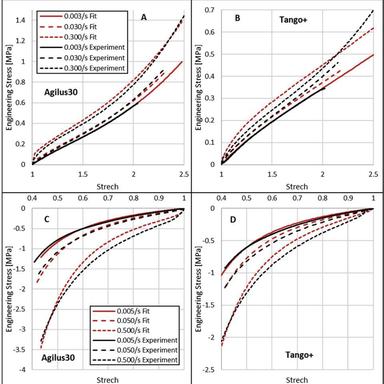
The visco-hyperelastic material model prediction vs. experiment for A30 and T+ tensile (A,B) and compressive (C,D) responses at various strain rates.